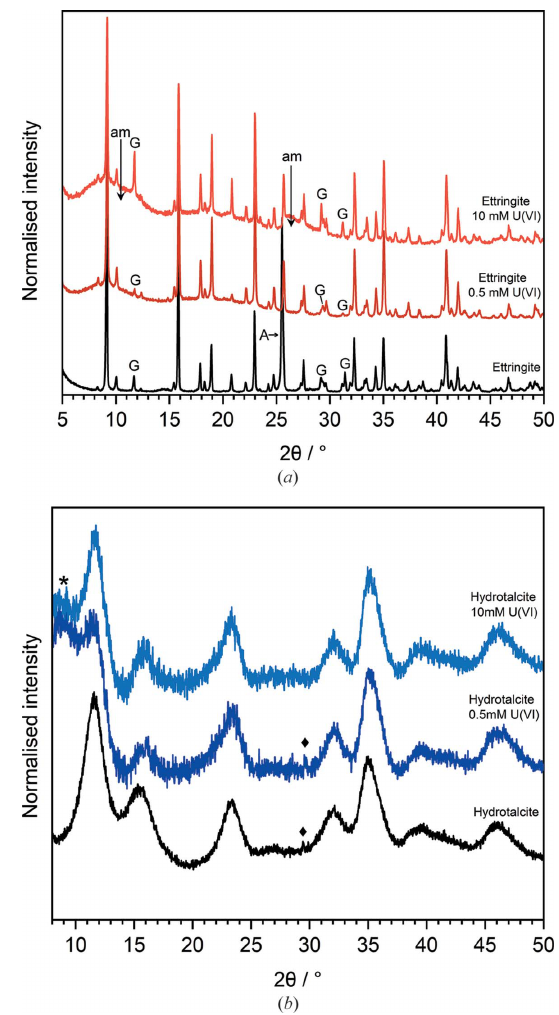
Figure 4 XRD patterns of ( a ) ettringite [PDF No. 04-013-3691 (Goetz- Neunhoeffer et al. , 2006)] and ( b ) hydrotalcite [PDF No. 01-082-8041 (Taylor, 1973)], before and after contact with U VI at 0.5 m M and 10 m M . A = anhydrite [CaSO 4 ; PDF No. 00-037-1496 (McMurdie et al. , 1986)]; G = gypsum [CaSO 4 (cid:2) 2H 2 O; PDF No. 00-033-0311 (Morris et al. , 1980)]. Diffraction patterns are normalized to the maximum peak intensity in both systems. In ( a ), regions of diffuse scattering are a result of sample preparation methods for radioactive samples unless denoted by ‘am’. In ( b ), background subtraction was performed on the diffraction patterns to highlight the diffuse diffraction peaks. The black diamond symbol indicates an unidentified phase and the asterisk indicates the background from sample preparation methods that could not be